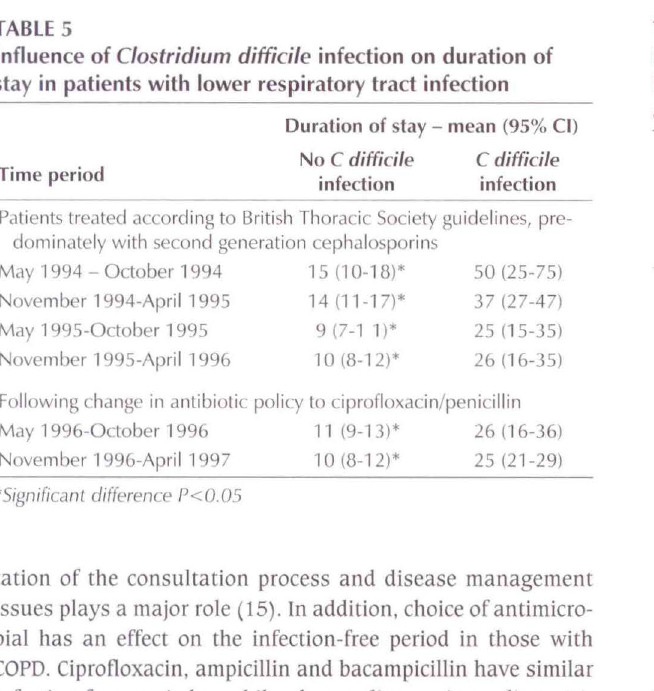
Influence of Clostridium difficile infection on duration of Incidence of Clostridium difficile infection in patients with stay in patients with lower respiratory tract infection lower respiratory tract infection and percentage of bed days attributed to those with infection Duration of stay - mean (95% Cl) No C difficile C difficile Time period infection infection Time